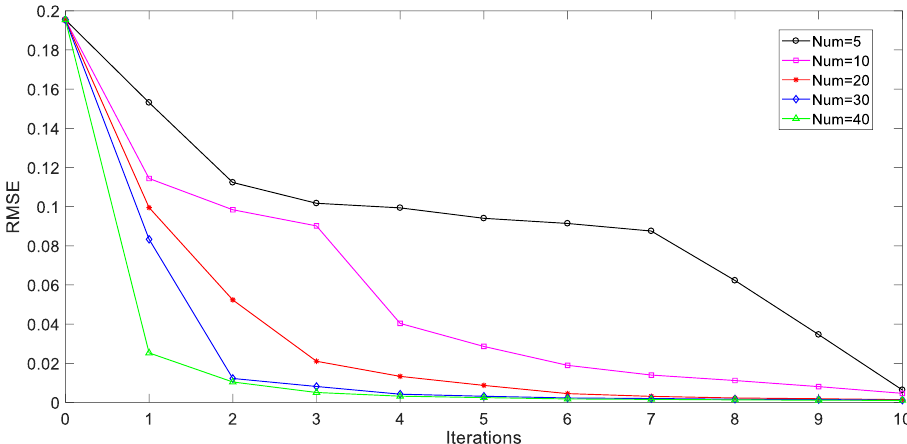
Figure 8. RMSE values of penicillin concentration for the AL based soft sensors under different number of selected samples.